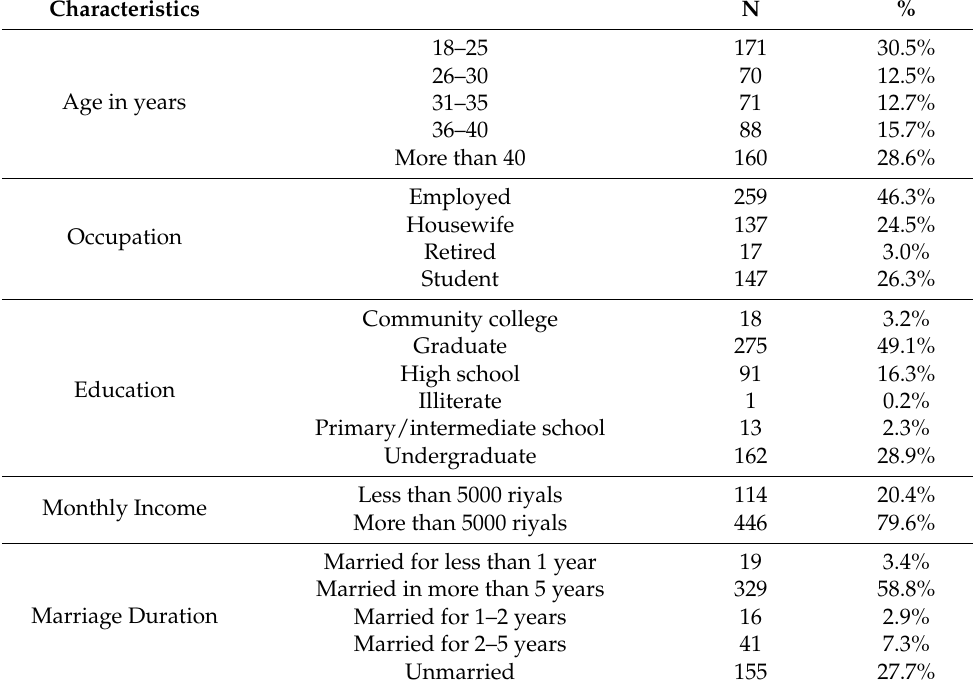
Table 1. Demographic